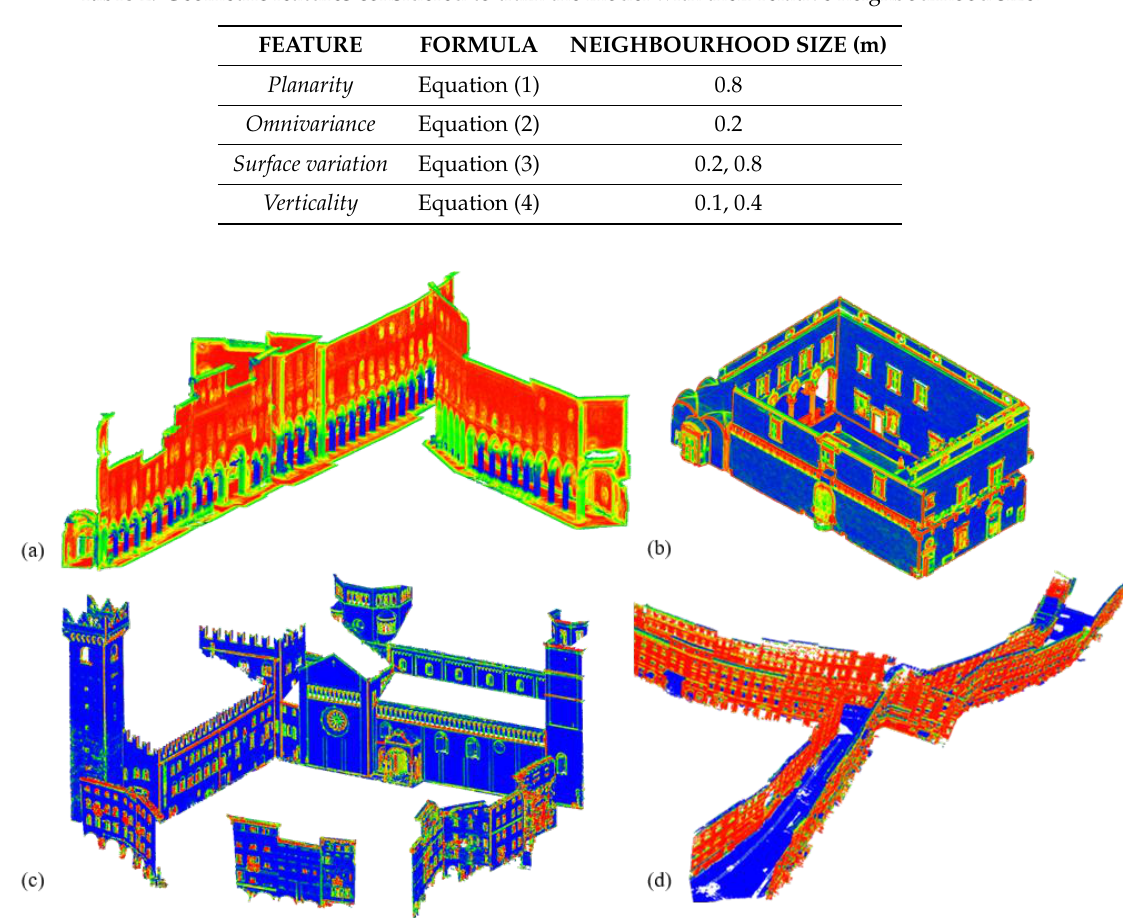
Figure 7. Example of the geometric features used for the classification procedure on Table 1 datasets: ( a ) planarity : it can facilitate the identification of arches and columns; ( b ) omnivariance and ( c ) surface variation: they highlight the discontinuities between the walls, mouldings and the windows; ( d ) verticality : it is essential to distinguish floors from facades.